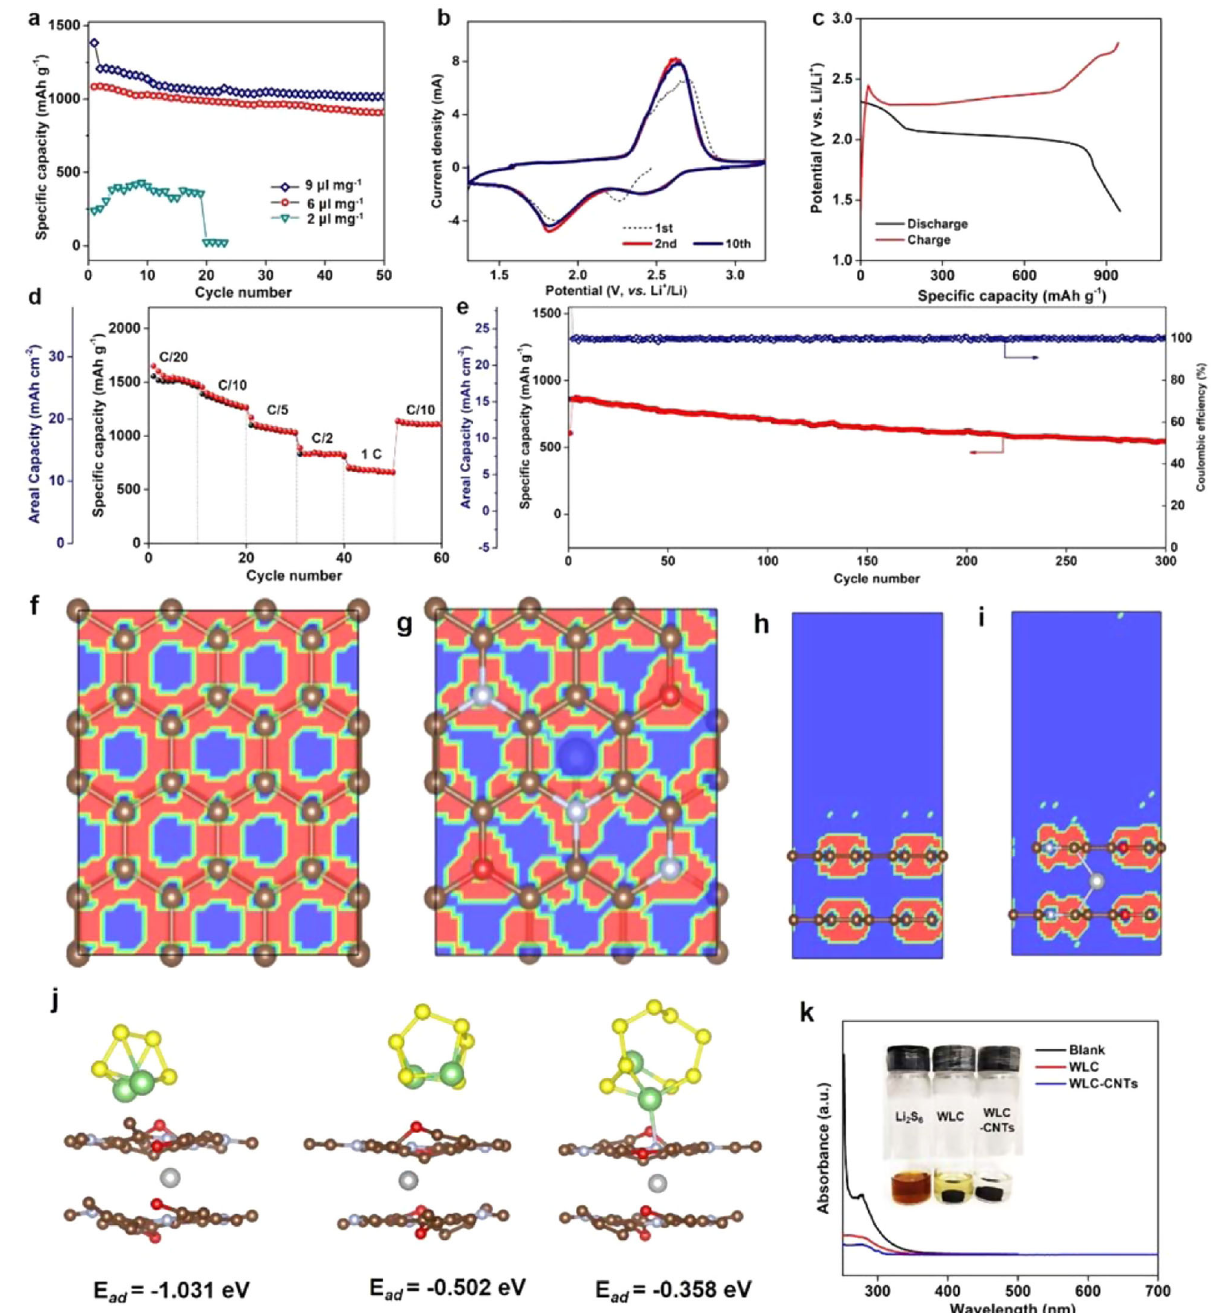
Fig. 3 Electrochemical performance of S@WLC-CNTs with a thickness of 400 μ m and sulfur loading of 17.3 mg cm − 2 . a Cycling performance with different amounts of electrolyte at 0.1 C (1 C = 1650 mAh g − 1 ); b CV curves; c 3rd charge and discharge curves at 0.1 C; d rate performance; e long-cycling performance at 0.2 C. ELF plot of a two-dimensional cut of f carbon along the ab plane, g WLC-CNTs along the ab plane, h carbon along the bc plane, and i WLC-CNTs along the bc plane. j Theoretical calculation of the adsorption energies of Li 2 S n ( n = 4, 6, and 8) on the surface of WLC-CNTs (carbon is brown, sulfur is yellow, lithium is green, oxygen is red, nitrogen is light blue, and nickel is gray between two carbon layers). k Ultraviolet-visible (UV − Vis) absorption spectra of the Li 2 S 6 solution after addition of WLC and WLC-CNTs for 1